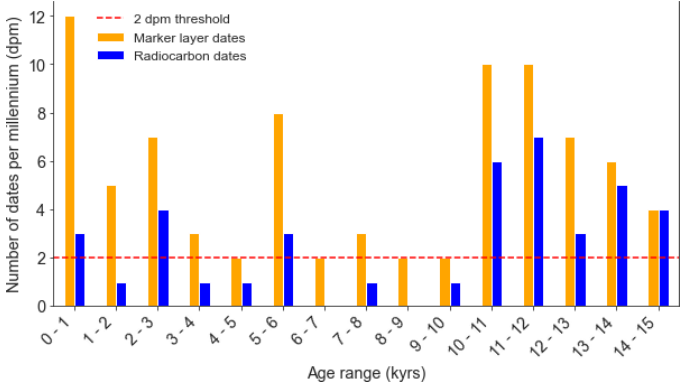
Figure 3. Number of dating points per millennium (dpm) of HZM19 for marker layers ( n : 84; mean: 5.5dpm) and radiocarbon dates ( n : 41; mean: 2.7dpm). The dotted red line marks the recommended threshold of 2dpm for Bayesian modelling suggested by Blaauw et al. (2018). Surface age and three ages estimated by Cs-137 are excluded.